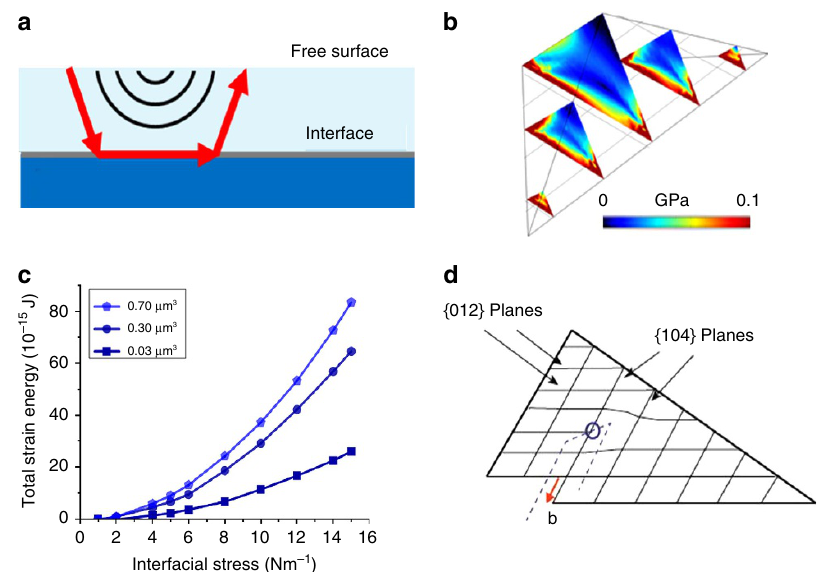
Figure 5 | Dislocation geometry. ( a ) Schematic of a classical ‘epitaxy’ misfit dislocations (red arrow), between two materials with a close lattice match. ( b ) Calculated stress distribution inside a calcite tetrahedron caused by an interfacial stress. The von Mises stress distribution is shown in vertical slices through the crystal. The interfacial stress was set to 10Nm (cid:2) 1 . ( c ) Total elastic energy, calculated using FE, due to interfacial stress for three different sized crystals. ( d ) Lattice planes on a cross-section of a (012) tetrahedron, showing the configuration of a dislocation on a (104) slip plane, with a (cid:2) 4 (cid:2) 21 (cid:2) vector. The blue circle shows where the dislocation line cuts the plane and the dashed line shows the dislocation line, which has screw character on the vertical segments and edge character on the horizontal segment (perpendicular to the plane). The red arrow shows the Burgers vector ( b ). This configuration is consistent with the experimental